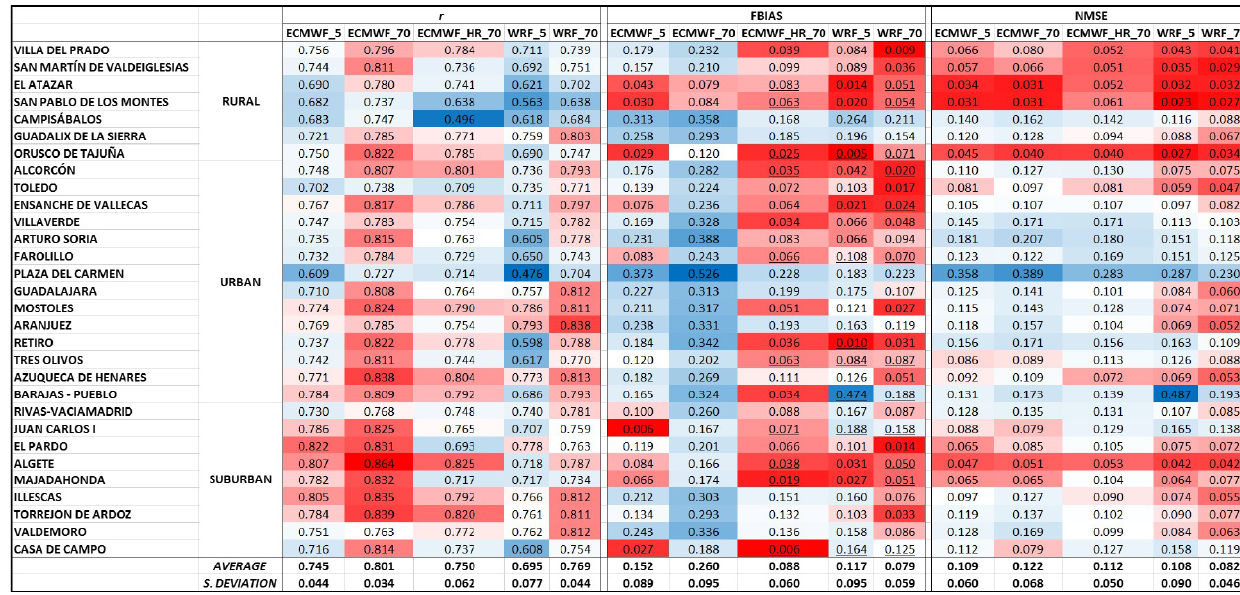
Table 3. Values of the Pearson correlation factor ( r ), fractional bias (FB) and normalised mean standard error (NMSE) of the comparison of the five LOTOS-EUROS simulations with observations of hourly O 3 data from 35 background monitoring stations located in the MAB. Colours illustrate the model agreement from blue (worst) to red